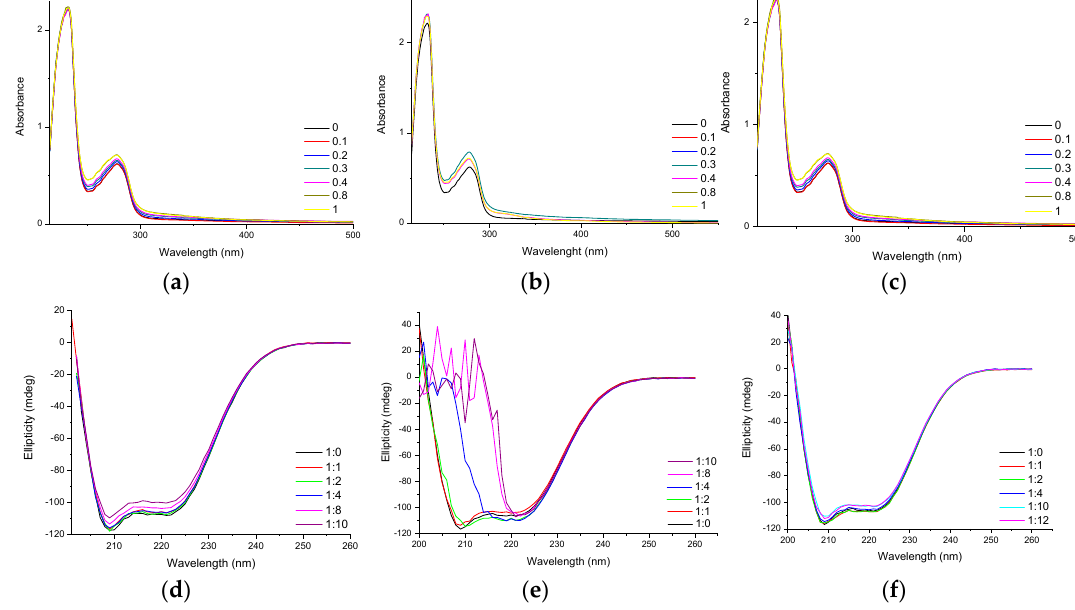
Figure 13. Changes in UV-Vis absorption spectra of HSA (2 × 10 -5 M) in Tris-HCl/NaCl buffer upon addition of 1 ( a ), 2 ( b ) and 3 ( c ) in different molar ratio and CD spectra of HSA incubated with 1 ( d ), 2 ( e ) and 3 ( f ) in different molar ratio.